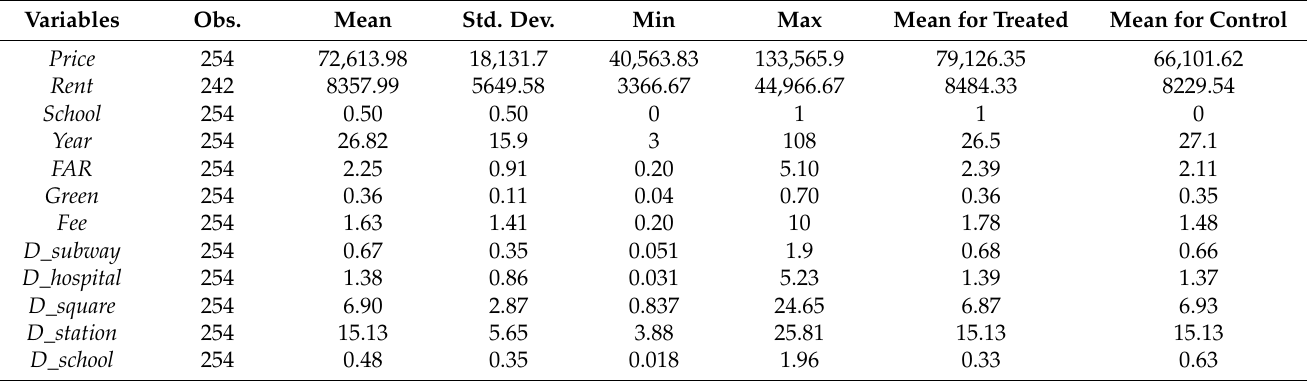
Table 2. Summary